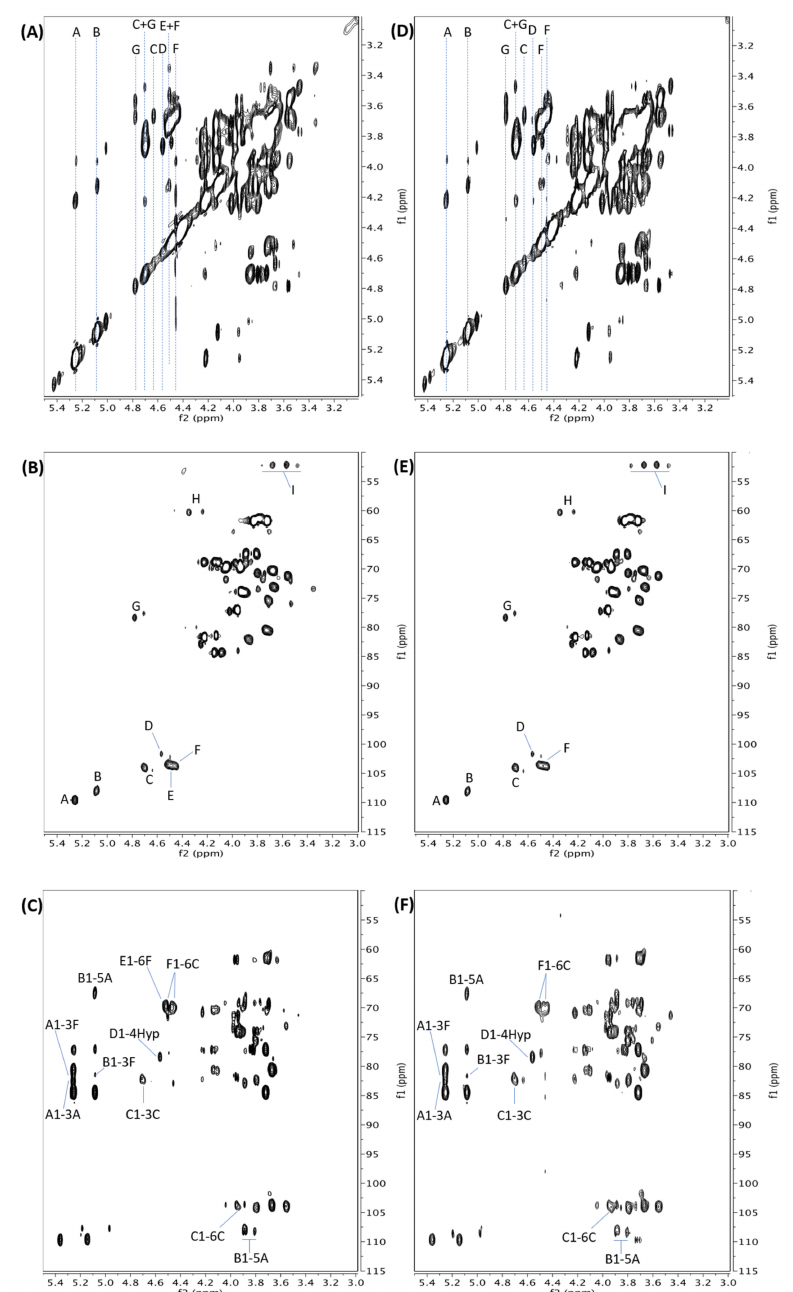
Figure 2. NMR spectra of AtSPHP-1 and -2 collected at 55 ◦ C. ( A – C ) Spectra of AtSPHP-1 and ( D – F ) spectra of AtSPHP-2. ( A , D ): TOCSY spectra; ( B , E ): HSQC spectra; ( C , F ): HMBC spectra. Inside each spectrum, A and B represent α -L-Ara f ; C as β -D-Gal p on galactan backbone; D as β -D-Gal p linked to Hyp; E as signals of β -D-Glc p A; F as signals side chain β -D-Gal p ; and G, H, and I as the signals Hyp at positions 4, 2, and 5, respectively. In ( C , F ), each label represents a glycosidic linkage between two glycosyl residues, i.e., A1-3A represents HMBC correlation corresponding to Ara f -(1 → 3)-Ara f